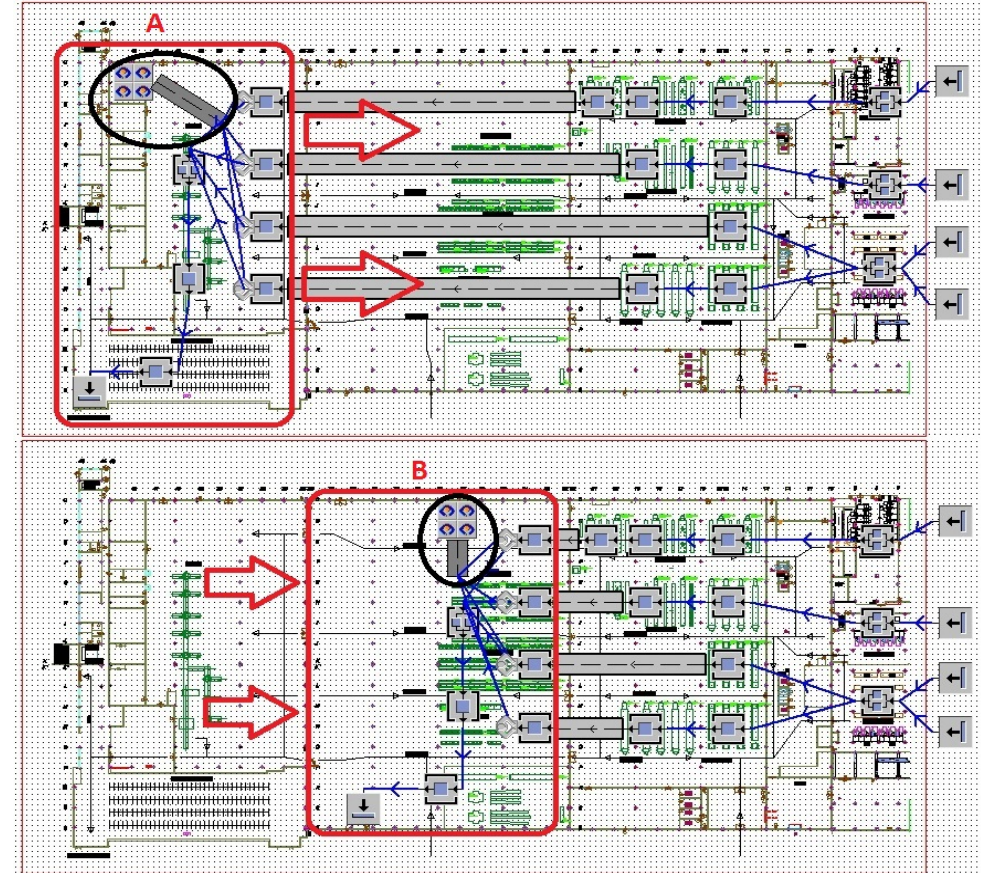
Figure 8. Relocation of workplaces in the production hall.